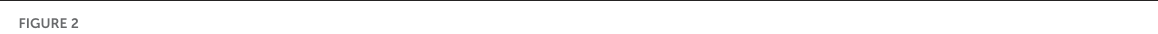
FIGURE2 respectively, based on 1,000 re-samplings. The scale bar represents 10% estimated sequence divergence as inferred from maximum likelihood analysis. Geobacter metallireducens (NCBI accession L07834; not shown) were used as an outgroup. Bubble plots show percent relative sequence abundance and succession of 21 Bacillota ASVs enriched in the heated slurry incubations. Sequence abundances of Non- Bacillota taxa are shown in Supplementary Figure